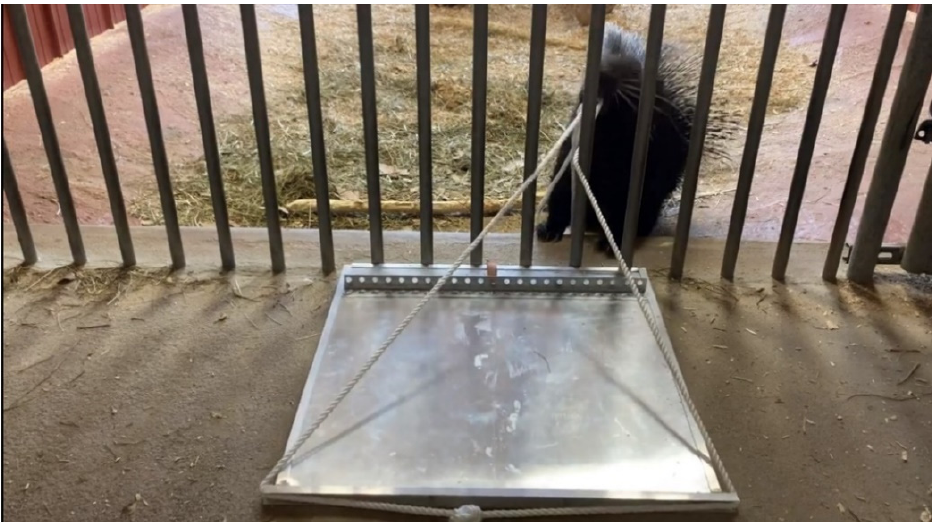
Figure 2. Apparatus used in Phase 1 and first 4 sessions of Phase